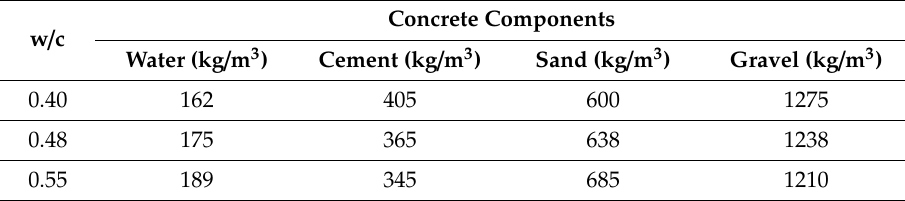
Table 2. Mixture proportions of concrete in the present study.